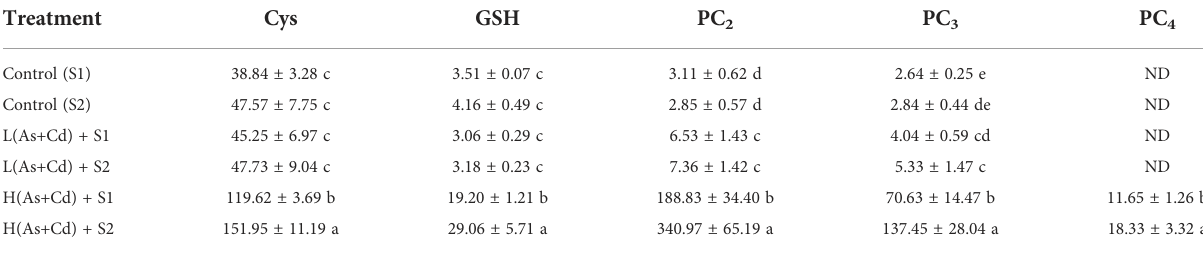
TABLE 2 Concentrations of thiol (-SH) compounds in the roots of wheat plants grown in de fi cient S or suf fi cient S nutrient solution after 6 days of As plus Cd exposure (nmol SH g – 1 FW). Treatment